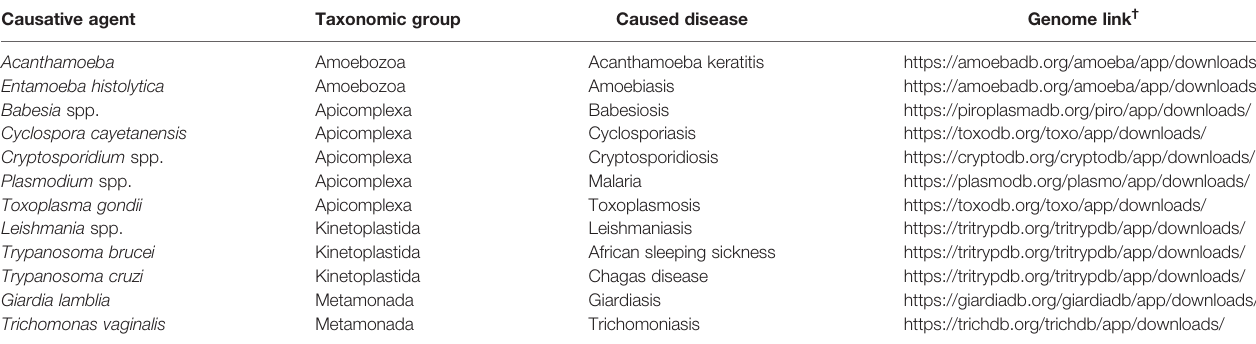
TABLE 1 | An overview of main human protozoan parasites and the available genome links. Causative